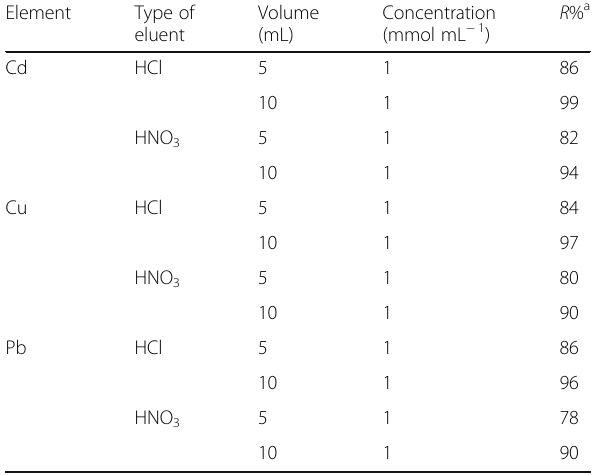
Table 1 Effect of the type, concentration, and volume of the elution solution on the recovery of Cd, Cu, and Pb ions [sample volume, 50 mL; amount of the metals 10 μ g of Cd, Cu, and Pb; pH 8 for Cd, Cu, and Pb] Element